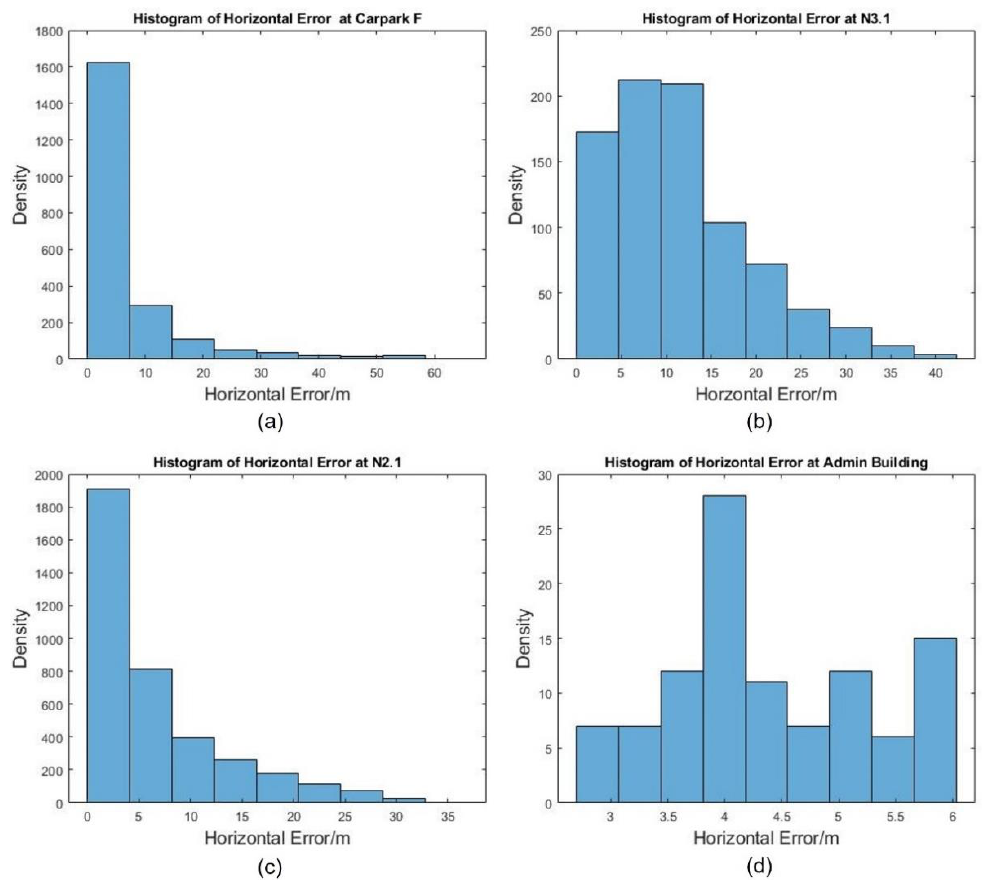
Figure 10. Histograms of Horizontal Position Errors at the 4 Locations: ( a ) Car Park F, ( b ) N3.1, ( c ) N2.1 and ( d ) the Admin Building.